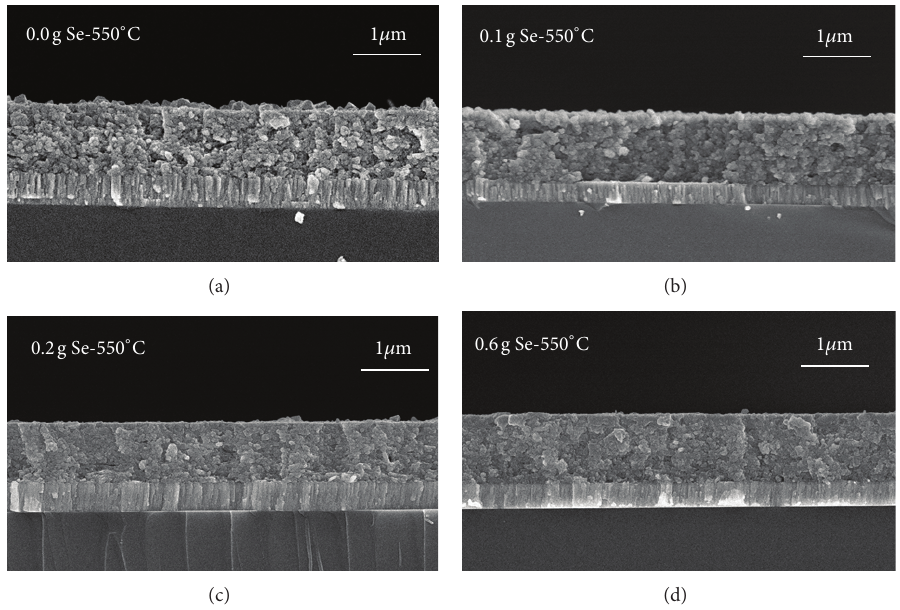
Figure 7: Cross-section observations of the CIS absorber layers as a function of extra Se content, the selenization temperature was 550 ∘ C.